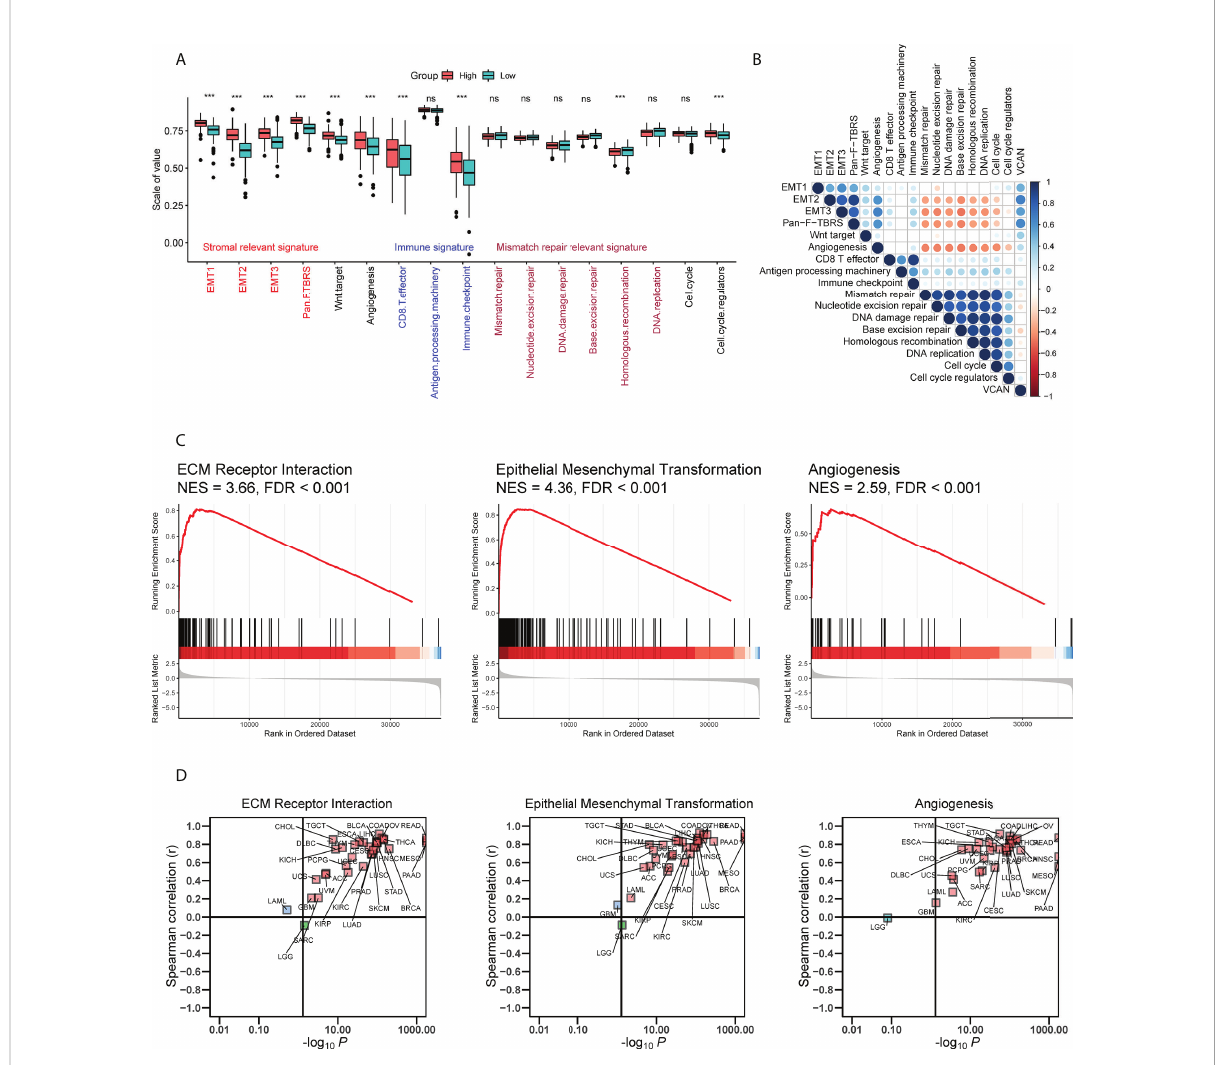
FIGURE 4 Potential mechanisms by which VCAN affected prognosis and response to anti-tumor therapy in GC. (A) The enrichment score of known biological processes in high VCAN group and low VCAN group in TCGA cohort. (B) The correlation between VCAN expression and the enrichment score of known biological processes in TCGA cohort. (C) Gene set enrichment analysis for patients with high VCAN expression and low expression in TCGA cohort. (D) The correlation between VCAN expression and the enrichment score of Extracellular Matrix (ECM) Receptor Interaction signaling, Epithelial Mesenchymal Transformation signaling and Angiogenesis signaling in human pan-cancer (Pan-cancer Atlas, TCGA). ***p <